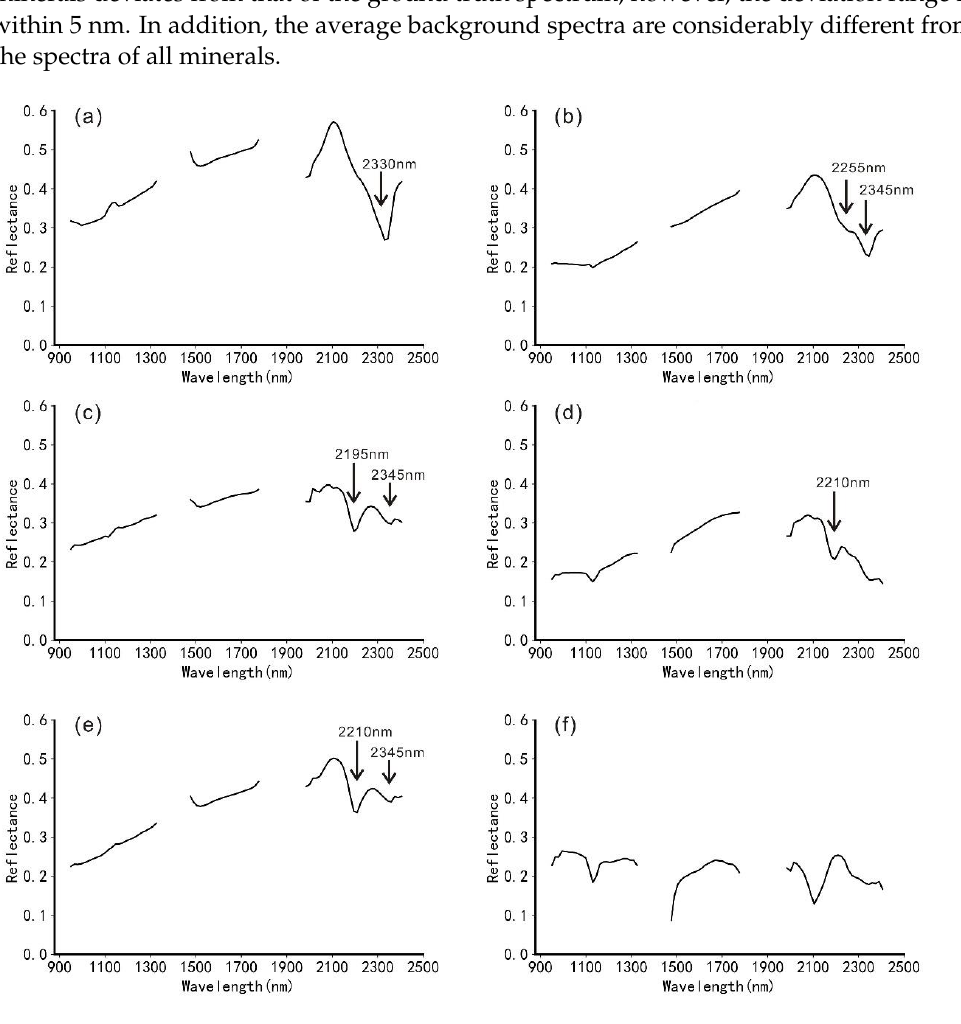
Figure 5. Sample mean spectrum. ( a ) Spectral curve of calcite. ( b ) Spectral curve of chlorite. ( c ) Spectral curve of short-wavelength white mica. ( d ) Spectral curve of montmorillonite. ( e ) Spectral curve of medium-wavelength white mica. ( f ) Spectral curve of the background.